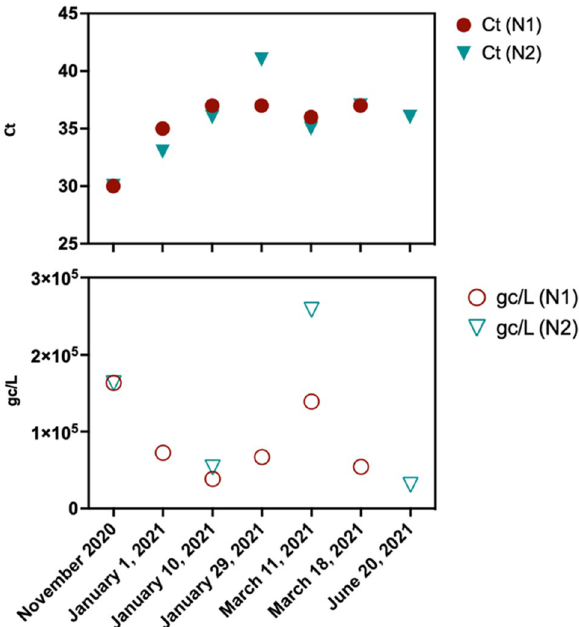
Figure 2. Detection of SARS-CoV-2 in the wastewater from November 2020 till June 2021, Ct values (top) with N1 and N2 primers in RT-qPCR, and the calculated genome copies/L (bottom) of the wastewater. Samples collected on November 2020, January 1, 2021, March 11, 2021, and June 20, 2021, were used to detect SARS- CoV-2 variants through enrichment and sequence